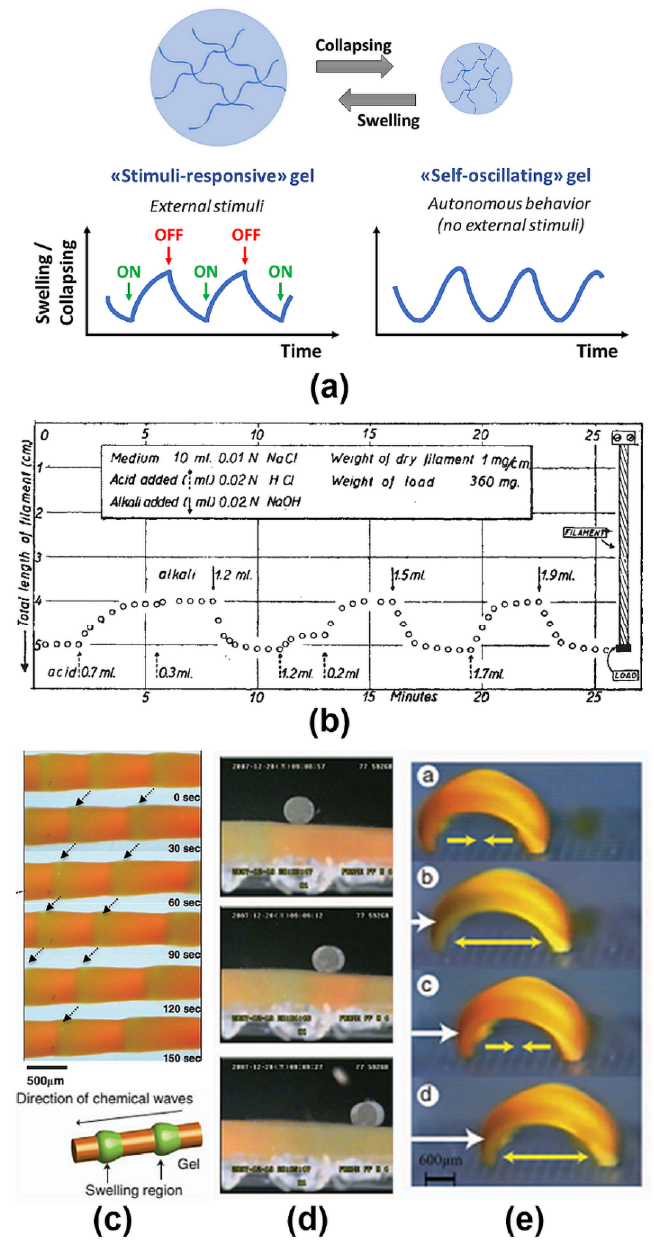
Figure 1. ( a ) Schematic representation of the conceptual difference between conventional, externally controlled gels and self-oscillating autonomous gels. Adapted from [37], Nature Publishing Group, 2014. ( b ) pH-Responsive polymer fibers as artificial muscles: the swelling and collapsing of chains, controlled by the external addition of bases or acids, results in mechanical movement (lowering and lifting of a load, respectively). Reproduced with permission from [7], Nature Publishing Group, 1950. ( c – e ) Self-oscillating gels, powered by the Belousov–Zhabotinsky reaction, as chemo-mechanical transducers: ( c ) peristaltic motion, ( d ) mass transport, ( e ) self-walking gel. Adapted and reproduced from [37], Nature Publishing Group,